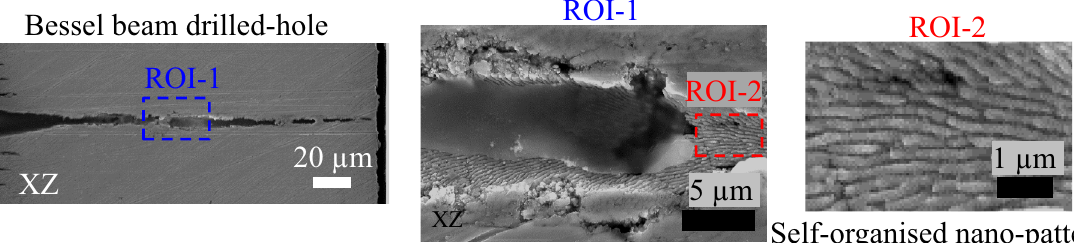
Figure 6. SEM cross-sectional image of the hole drilled through the 200 μm steel plate by the Bessel beam at the laser fluence F = 5.15 J/cm 2 (Left); Blow-up images in the ROI-1 (Middle) and ROI-2 (Right), showing the self-organized nano-structures induced by the self-replication of the Bessel